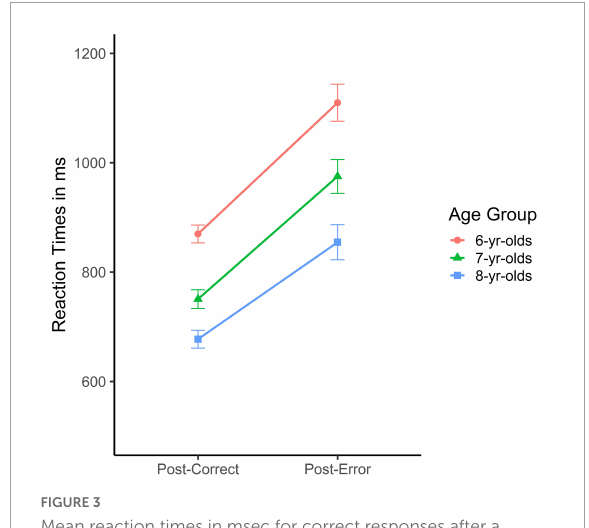
FIGURE3 Mean reaction times in msec for correct responses after a correct response (post-correct) vs. after an error (post-error) in the Flower block of the Heart and Flower task as a function of age group (error bars represent SEM) illustrating that children from all three age groups responded slower on post-error trials than on post-correct trials as the cognitive control demands varied strongly from trial to